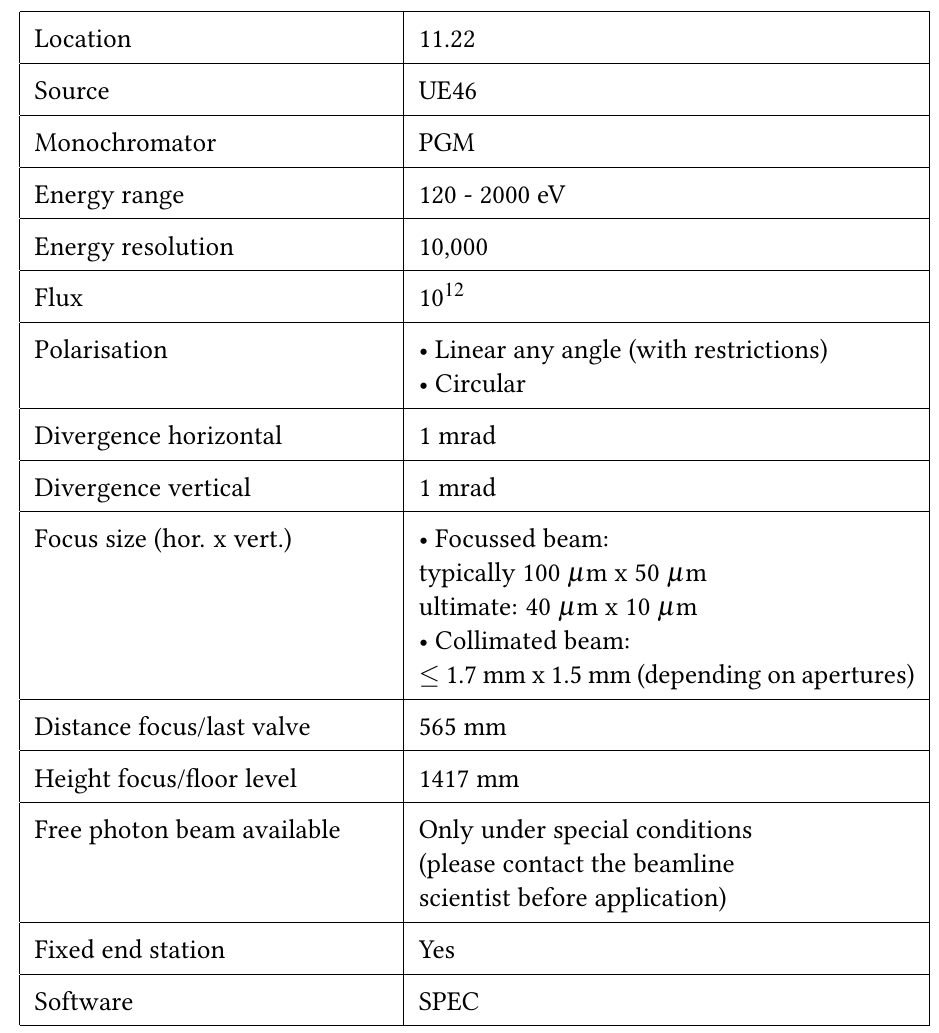
Table 2: Technical data of Beamline UE46